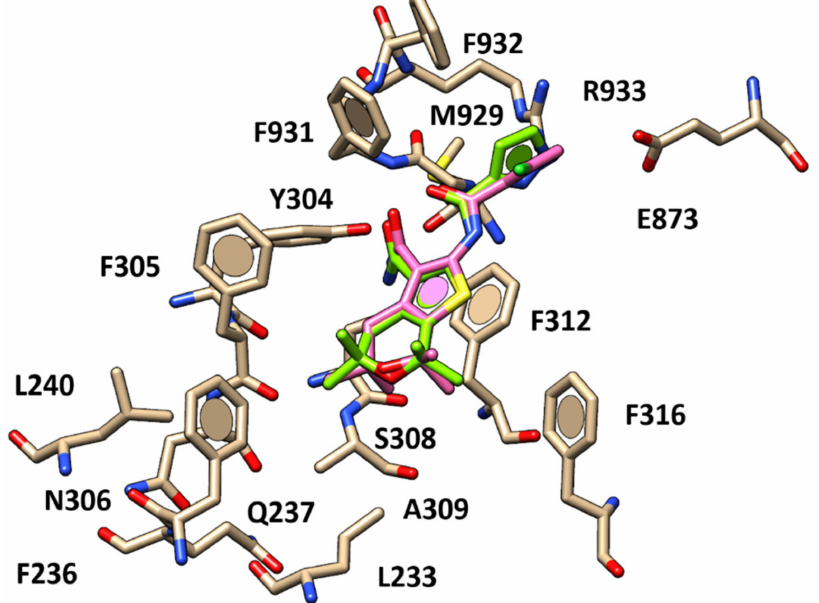
Figure 5. Docking positioning of compound 22 ( C atom; pink) compared to that of compound 11 ( C atom; green) within the human CFTR